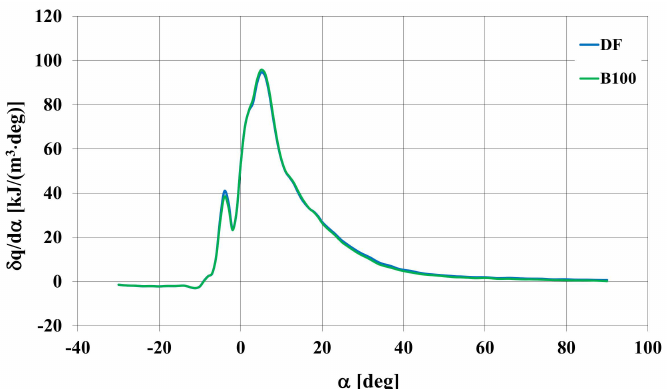
Figure 16. Process of the derivative of the pressure of the working factor in the cylinder-p g against the angle of rotation of the crankshaft-dp g /d α in the domain of the angle of rotation of the crankshaft-at the rotation speed of 3600 min − 1 for the engine powered with fuels DF diesel or B100.